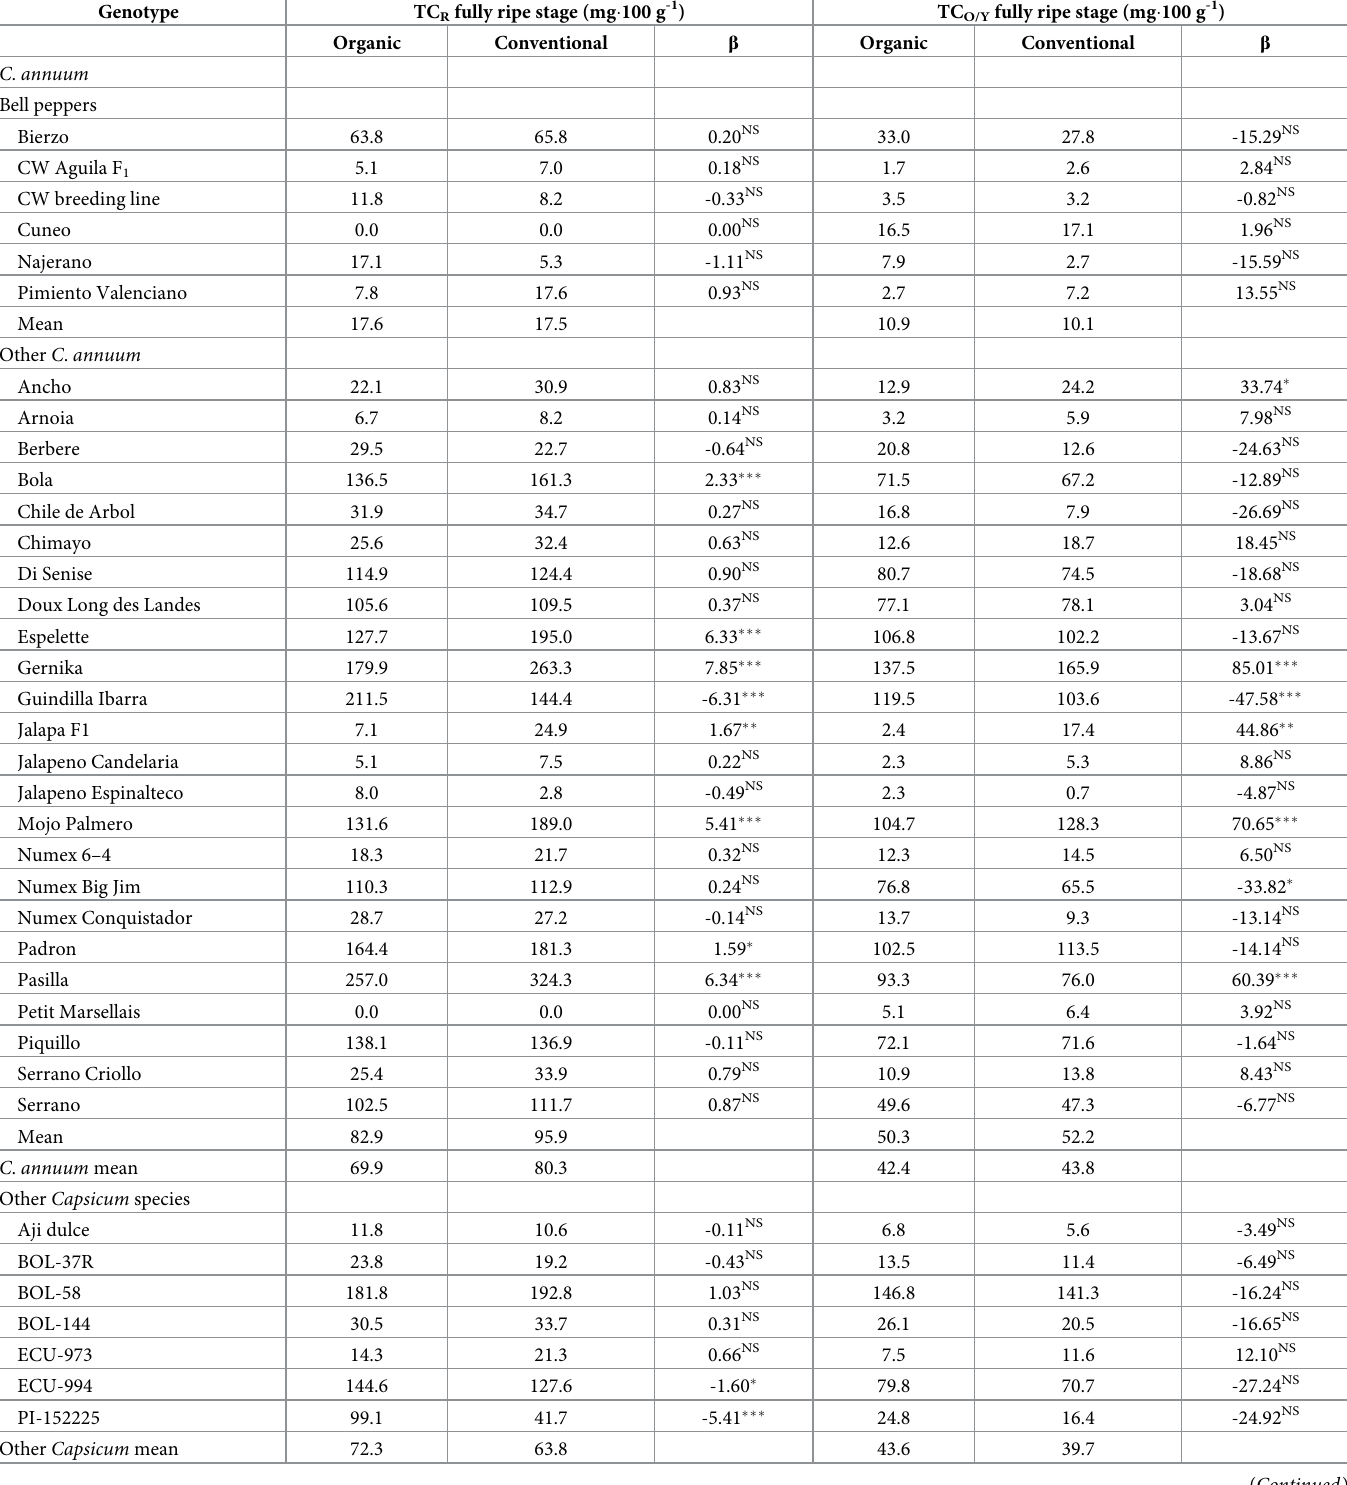
Table 5. Average content in total red carotenoids and yellow/orange carotenoids (TC R and TC Y/O , mg � 100 g -1 fresh weight) estimated in the unripe and fully ripe fruits from the peppers studied, evaluated under organic and conventional conditions and regression coefficient ( β ) based on environmental